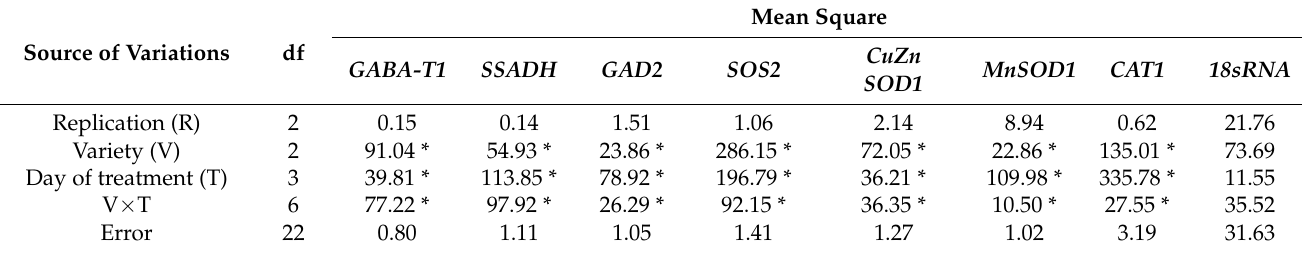
Table 6. ANOVA result of gene